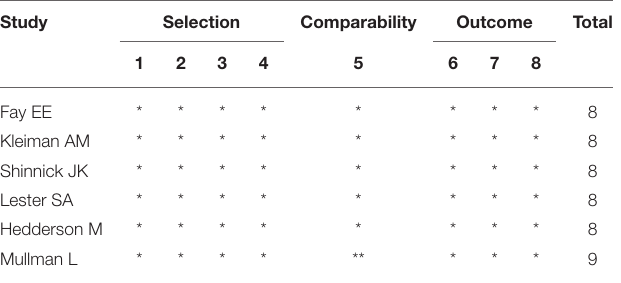
TABLE 2 | Quality assessment of non-randomized